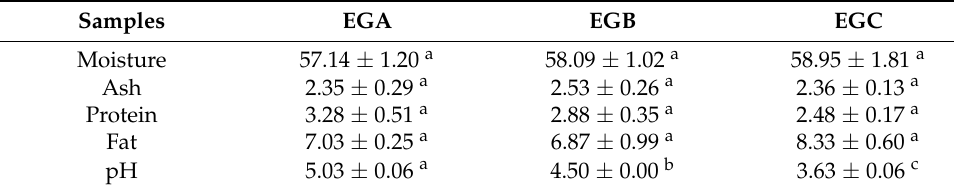
Table 1. Proximate compositions and pH values of EGA, EGB and